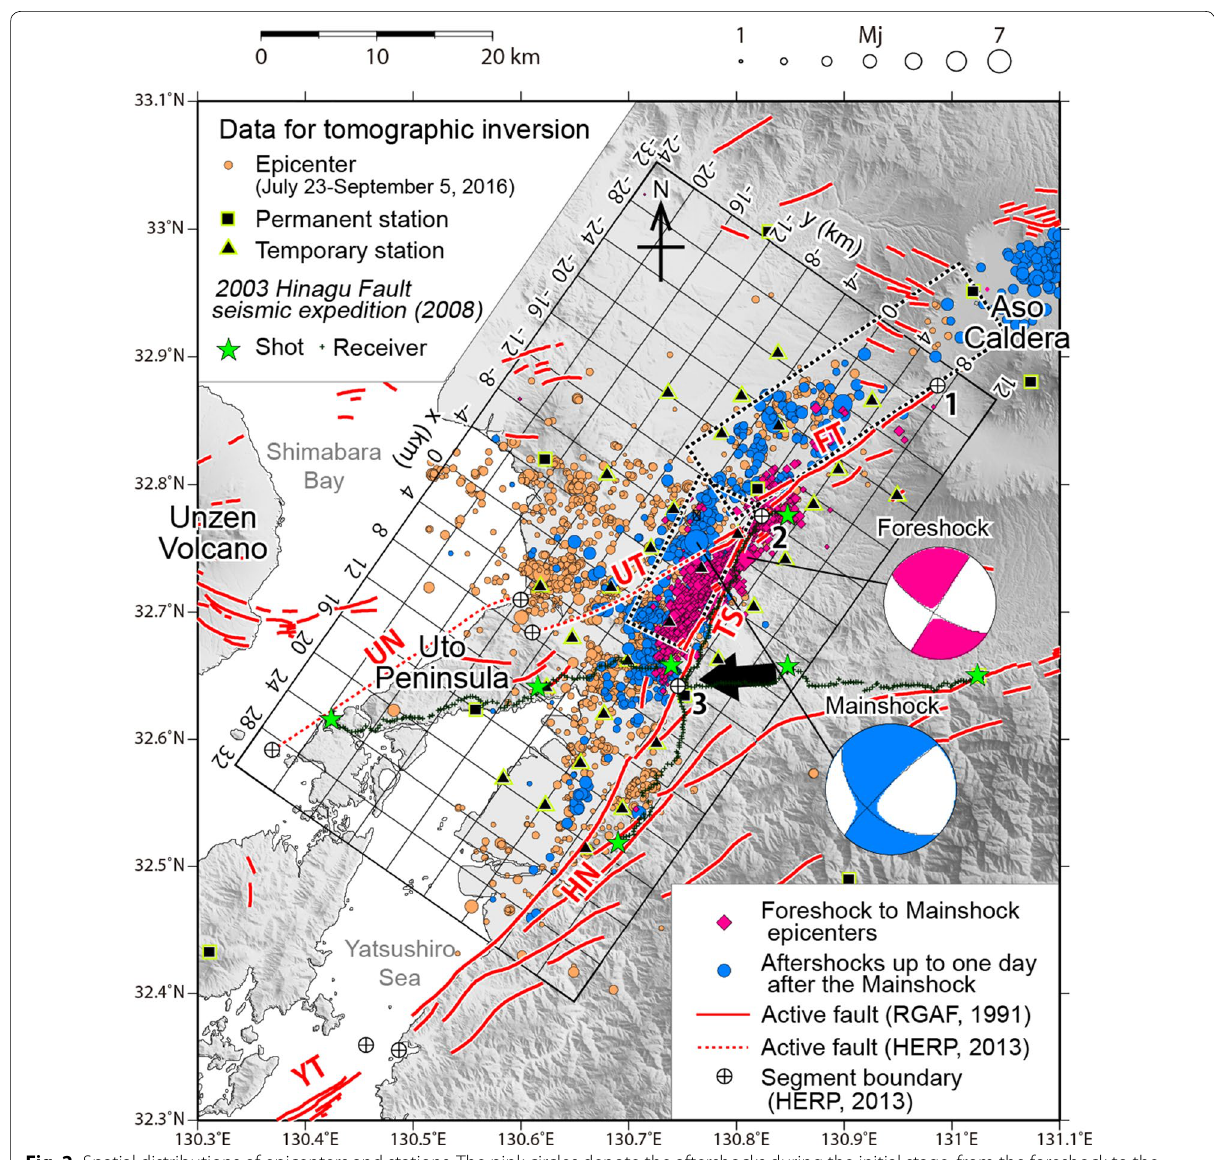
Fig. 2 Spatial distributions of epicenters and stations. The pink circles denote the aftershocks during the initial stage, from the foreshock to the mainshock, and the blue circles denote the aftershocks that occurred up to one day after the mainshock. The pink and blue beachballs are the moment tensor solutions of the foreshock and mainshock, respectively, as determined by F-net of NIED (Fukuyama et al. 1998). The aftershocks that occurred during our temporary seismic station deployment (July 23–September 5, 2016) are shown in orange. The locations of the dynamite shots and receiver lines during the 2003 Hinagu Fault Seismic Expedition (RGHFSE 2008) are indicated by the green stars and crosses, respectively. The dotted rectangles represent the surface projection of the source fault planes for the mainshock in Asano and Iwata (2016). The southern termination of the fault rupture, which is estimated during our study, is indicated by the black arrow. The grid lines show the coordinates for the tomographic inversion in this study. The solid and dashed red lines denote the active faults determined by RGAF (1991) and HERP (2013), respectively. FT Futagawa segment, UT Uto segment, UN north coast of Uto Peninsula segment, TS Takano–Shirahata segment, HN Hinagu segment, YT Yatsushiro